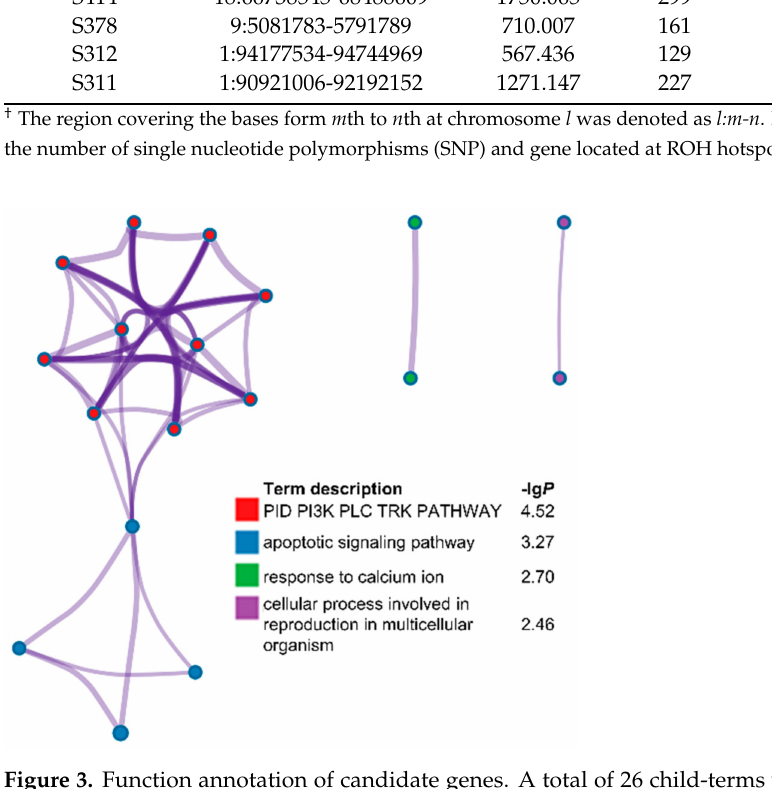
Figure 3. Function annotation of candidate genes. A total of 26 child-terms were returned which were summarized into four parent-terms (Table S3).